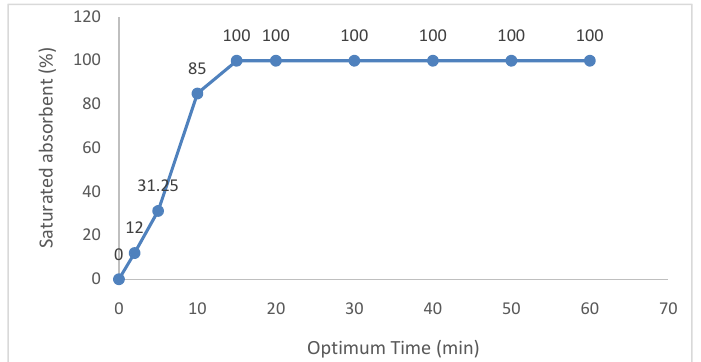
Fig. 4. Kinetics of ceftriaxone onto Fe₃O₄@[NVC][AP]